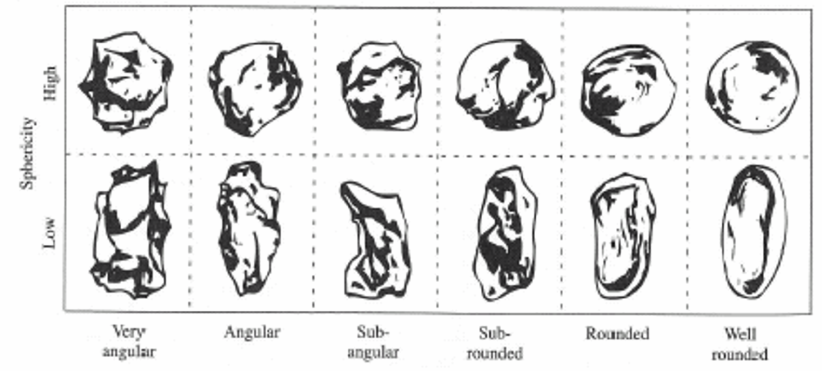
Figure 1. Sand particleshape in terms of sphericity, angularity and roundness